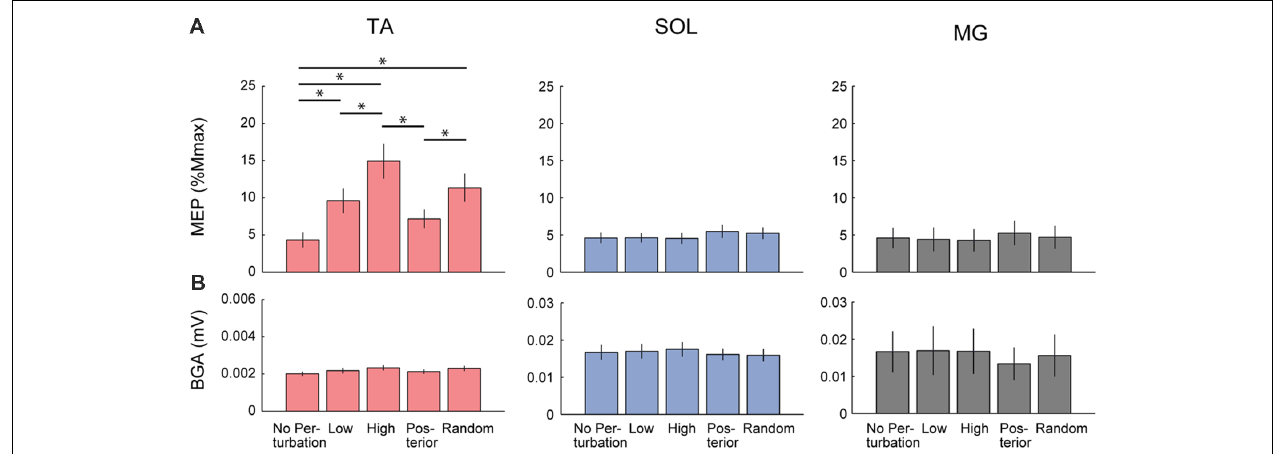
FIGURE 3 | Comparison of the Group average of the MEP (A) and the background EMG activity (BGA; B ) in each muscle among the five conditions. Significant differences were observed in the TA-MEP. TA, tibialis anterior; SOL, soleus; MG, medial gastrocnemius. Asterisks indicate the statistically significant differences between conditions.